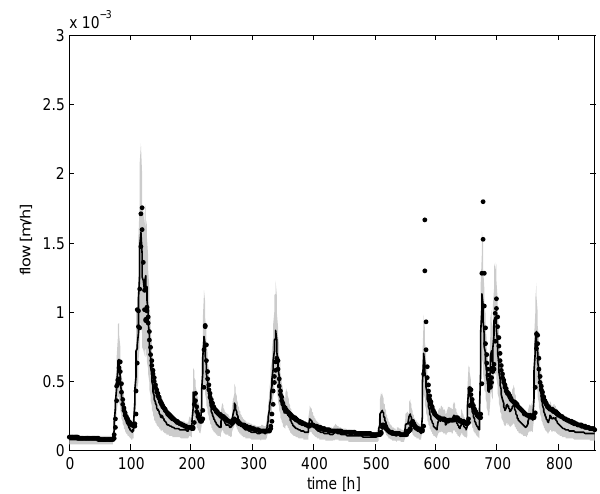
Fig. 3. Validation of the DBM model on October–November 1991 period, 79% of output variation explained; dots denote the obser- vations, simulations are marked by a solid black line, shaded area denotes 95% confidence